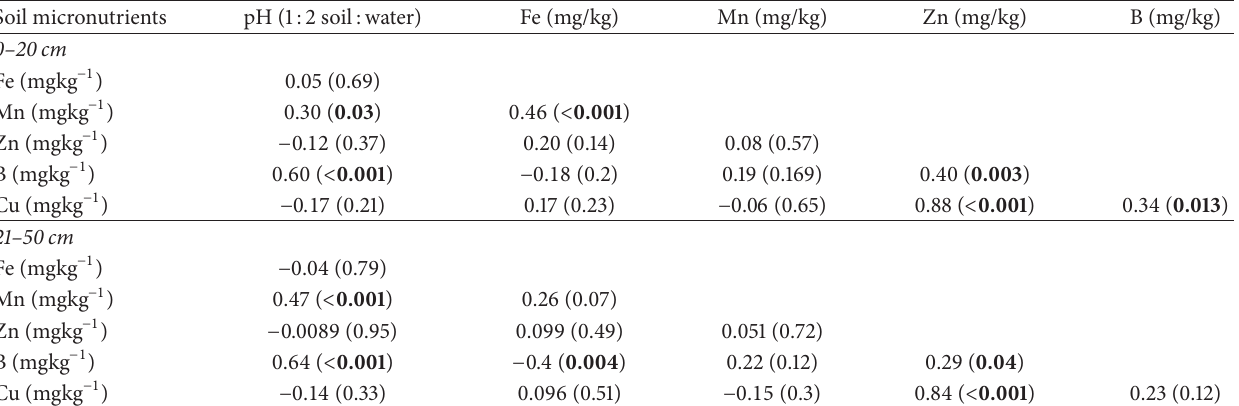
Table 3: Pearson product-moment correlation coefficient among soil properties on the southern slopes of Mount Kilimanjaro, Tanzania. Soil